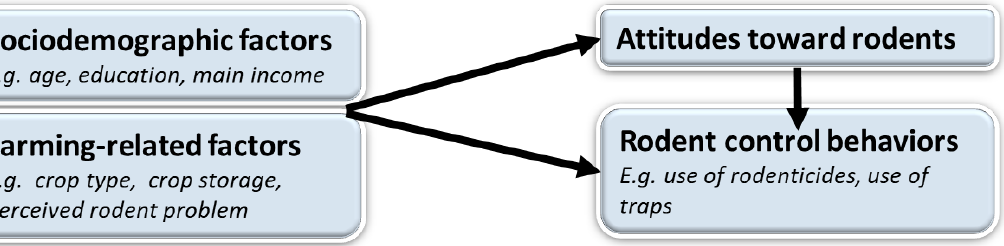
Figure 1. Conceptual framework for associations between different parameters of farmers from the survey ( n = 126). Both ‘sociodemographic factors’ and ‘farming-related factors’ are delineated as independent variables. Arrows indicate potential explanatory